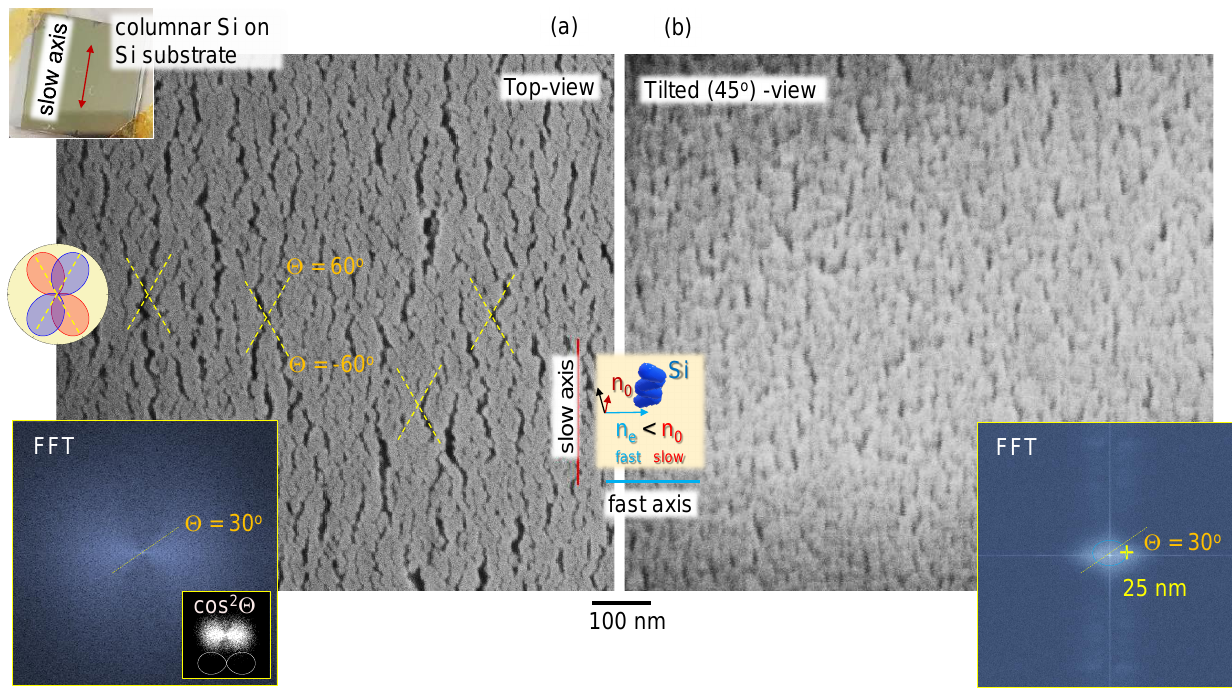
Figure 3. Surface morphology of columnar Si film on Si substrate. ( a ) SEM images of a ∼ 1 µ m-thick columnar Si (top-left inset photo of 1 × 1 cm 2 sample); no metal coating was used for SEM imaging; side-insets show fast Fourier transform (FFT) images of top and slanted view images; ( b ) high-contrast FFT image (top-view SEM) shows an overlaid cos 2 θ polar plot. Center-inset shows orientation of the columnar Si coating. The cross-markers (dashed lines) on the top-view image show orientations of crevices at ± 60 ◦ orientations and corresponding dipole profiles cos 2 ( θ ± 60 ◦ )